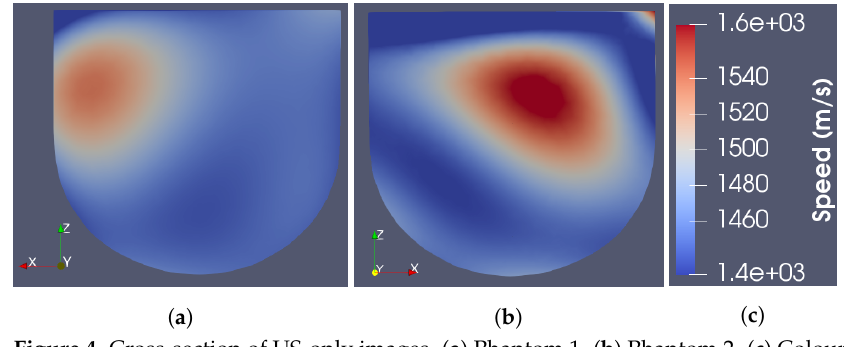
Figure 4. Cross-section of US-only images. ( a ) Phantom 1. ( b ) Phantom 2. ( c ) Colour bar.